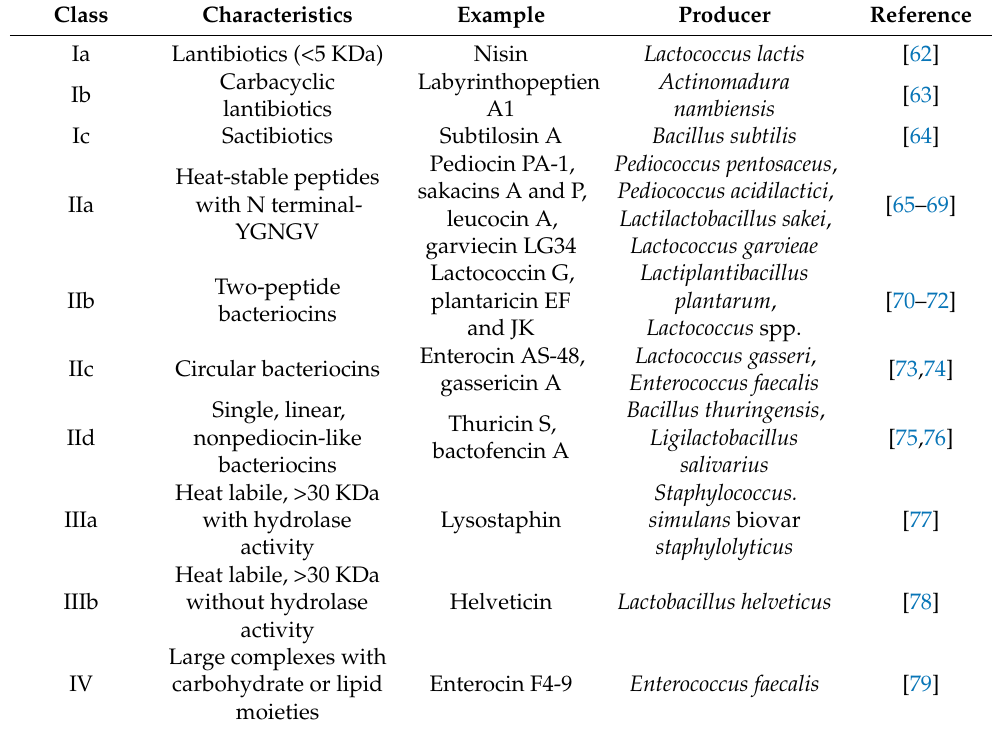
Table 3. Bacteriocins classification, main features, examples of different bacteriocins, and their producer